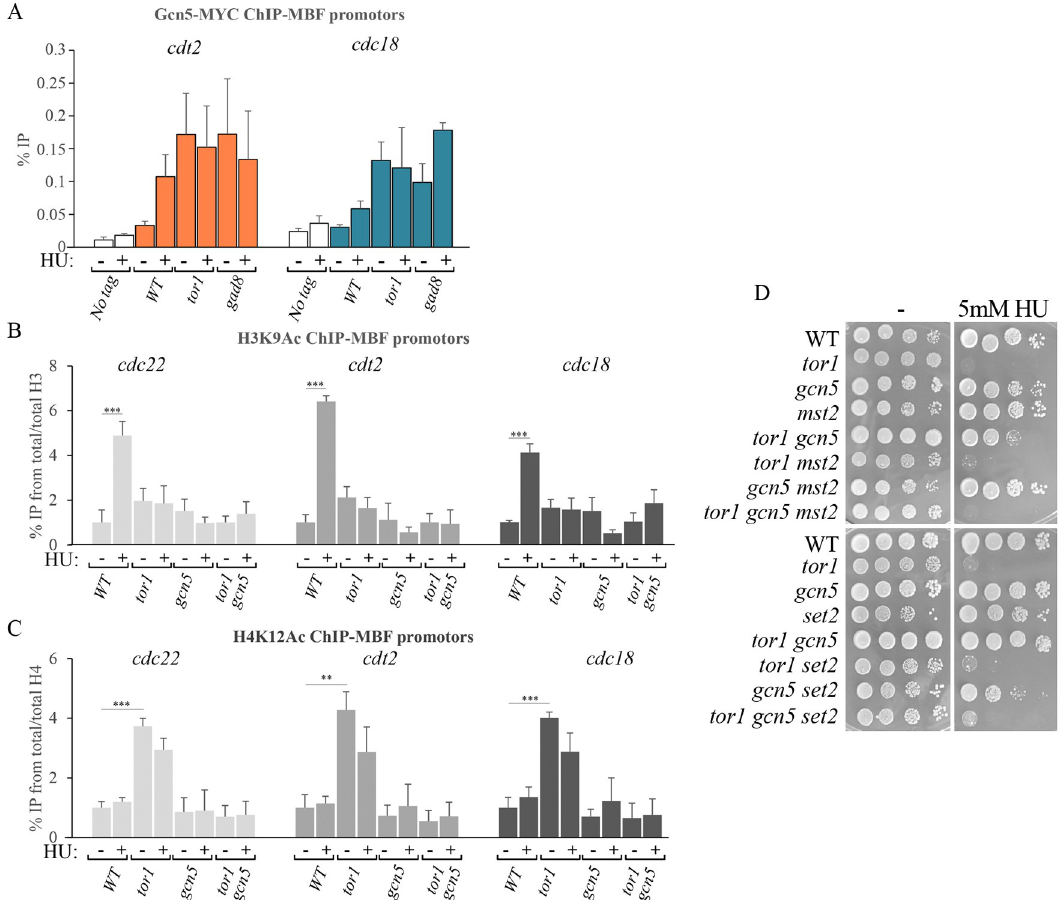
Fig 5. High levels of Gcn5 binding and abnormal transcription-associated chromatin modifications at MBF-regulated promoters in TORC2 mutant cells. ( A ) Loading of Gcn5 at the promoters of cdt2 + and cdc18 + was measured by chromatin immunoprecipitation (ChIP) analysis of chromatin extracts isolated from untagged cells (No tag), or wild type cells carrying Gcn5-MYC (WT), or the indicated mutant cells carrying Gcn5-MYC. Cells were untreated (-) or treated with 12 mM HU for 3 hours (+). The level of binding is quantified on anti-MYC immunoprecipitated DNA by quantitative PCR. (B and C) Levels of H3K9Ac (B) and H4K12Ac (C) measured by ChIP-qPCR at MBF promoters in wild type and the indicated deletion mutant cells. Each value is the mean of at least three independent assays, and the error bars indicate standard deviation and significant differences were determined by the Students t-test ( � P < 0.05, �� P < 0.01, ��� P < 0.001). (D) Serial dilution of exponentially growing wild type and deletion mutant cells were spotted onto minimal medium, with or without 5 mM hydroxyurea